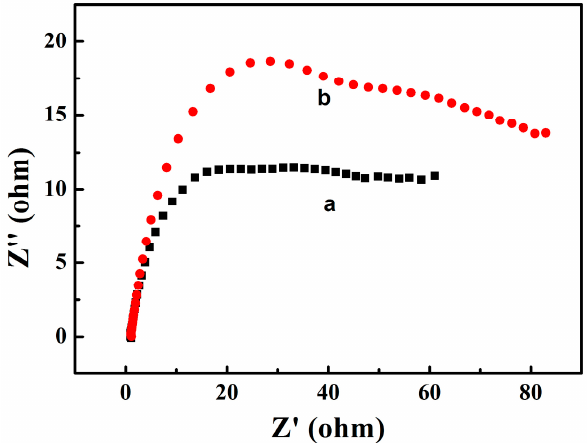
Figure 4. EIS of the zinc electrode in the aqueous electrolyte containing different dicarboxylates (a: disodium malonate; and b: disodium succinate).